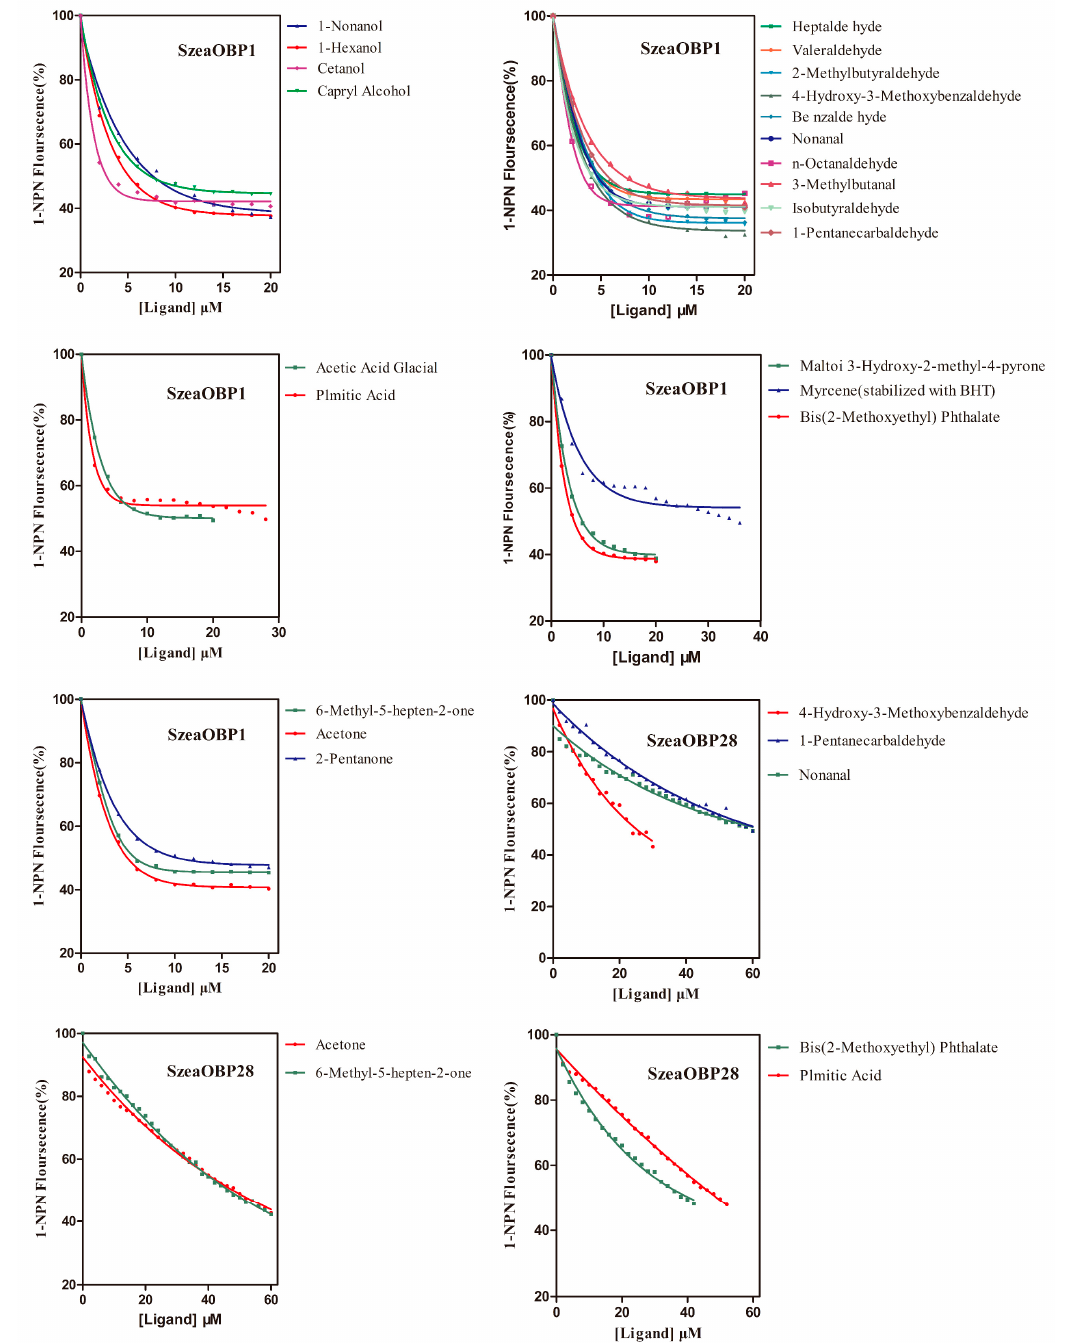
Figure 7. Fluorescence competitive binding curves of the two SzeaOBPs with host plant volatiles. The recombinant proteins and 1-NPN were diluted with 20 mM Tris-HCl buffer (pH 7.4) to a final concentration of 2 µ M. The mixed solution was titrated with each host plant volatile (1 mM) to a final concentration of 0–60 μ M.